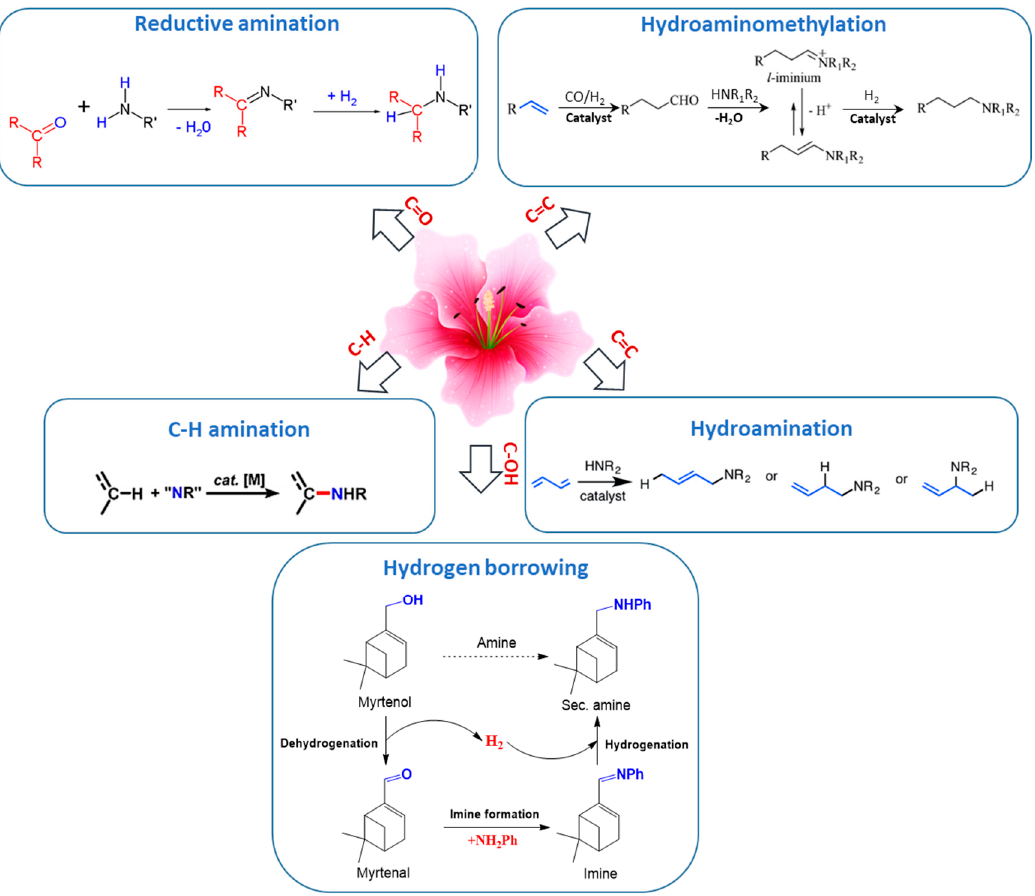
Figure 3. Overview of the available tools for amination of terpenoids.